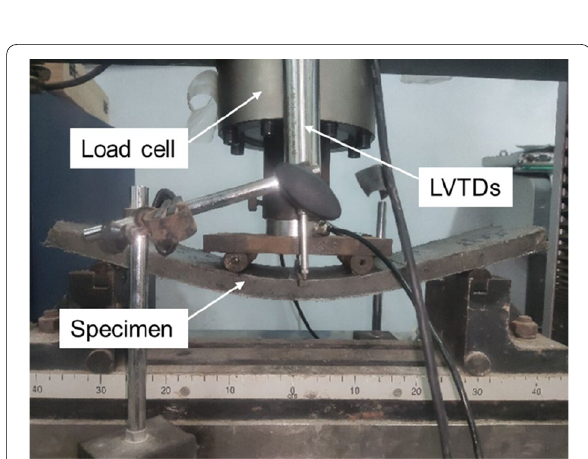
Fig. 4 Illustration of the four-point bending test for fibre-reinforced MPC mortar.